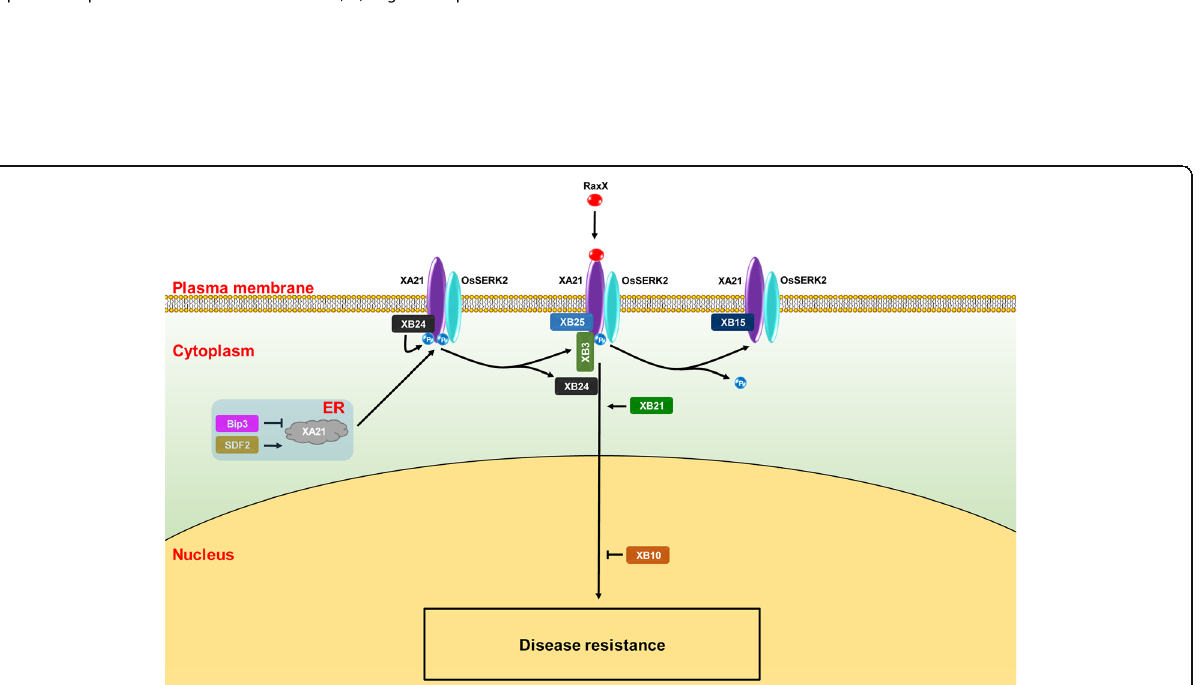
Fig. 2 Xa21 -mediated immune signaling pathways triggered by Xanthomonas oryzae . Sulphated RaxX is recognized by XA21 and activate XA21- mediated resistance. Several XA21 binding proteins, including OsSERK2, XB3, XB10, XB15, XB21, XB24, XB25, Bip3 and SDF2 are involved in regulating XA21-mediated resistance. XA21 is processed in endoplasmic reticulum, which is negatively and positively regulated by the ER chaperones BiP3 and SDF2, respectively. OsSERK2 positively regulates the immunity by forming a constitutive complex with XA21 and transphosphorylating XA21. XB24 binds to XA21 and promotes autophosphorylation of XA21 to keep it in an inactive state. During Xoo infection, XB24 dissociates from XA21. XB3 and XB25 are required for XA21 accumulation. XB15 dephosphorylates the autophosphorylated XA21 and attenuates the XA21-mediated resistance. XB21 functions as an auxilin to positively regulate XA21-mediated immunity. The transcription factor XB10/OsWRKY62 acts as a negative regulator XA21-mediated